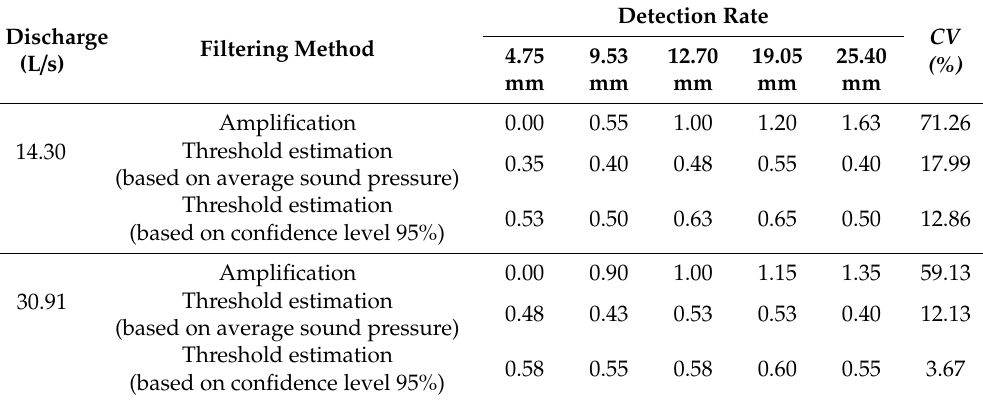
Table 5. Comparison of detection rates by acoustic signal filtering method.